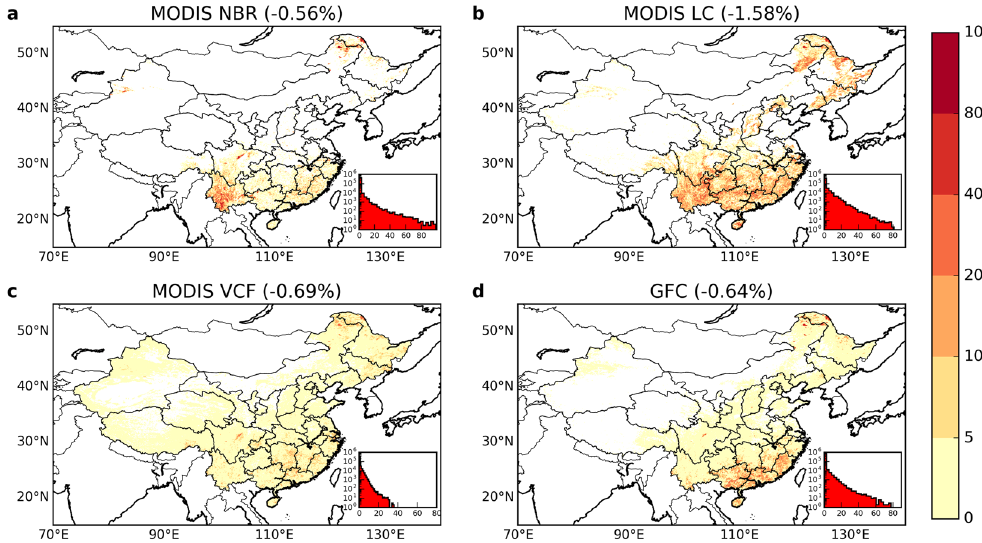
Figure 1. Spatial pattern in forest loss (%) in China between 2000 and 2013 from different satellite datasets. These patterns were computed from similar (but not identical) time periods: ( a ) MODIS NBR for 2000–2013, ( b ) MODIS LC for 2001–2012, ( c ) MODIS VCF for 2000–2013, ( d ) Landsat GFC for 2000–2012. The total forest loss area was 54,019 km 2 in MODIS NBR, 151,846 km 2 in MODIS LC, 65,948 km 2 in MODIS VCF, and 61,165 km 2 in GFC. The forest change results were aggregated to percentage at 5 km resolution for display purposes. The histogram in the inset (lower right of each panel) shows the corresponding count of 5 km pixels binned into categories of discrete forest loss percentages. The number in parenthesis after the title for each panel shows the corresponding change in national forest coverage based on the country area of 9.6 million km 2 . Maps were created using Python 2.7.11